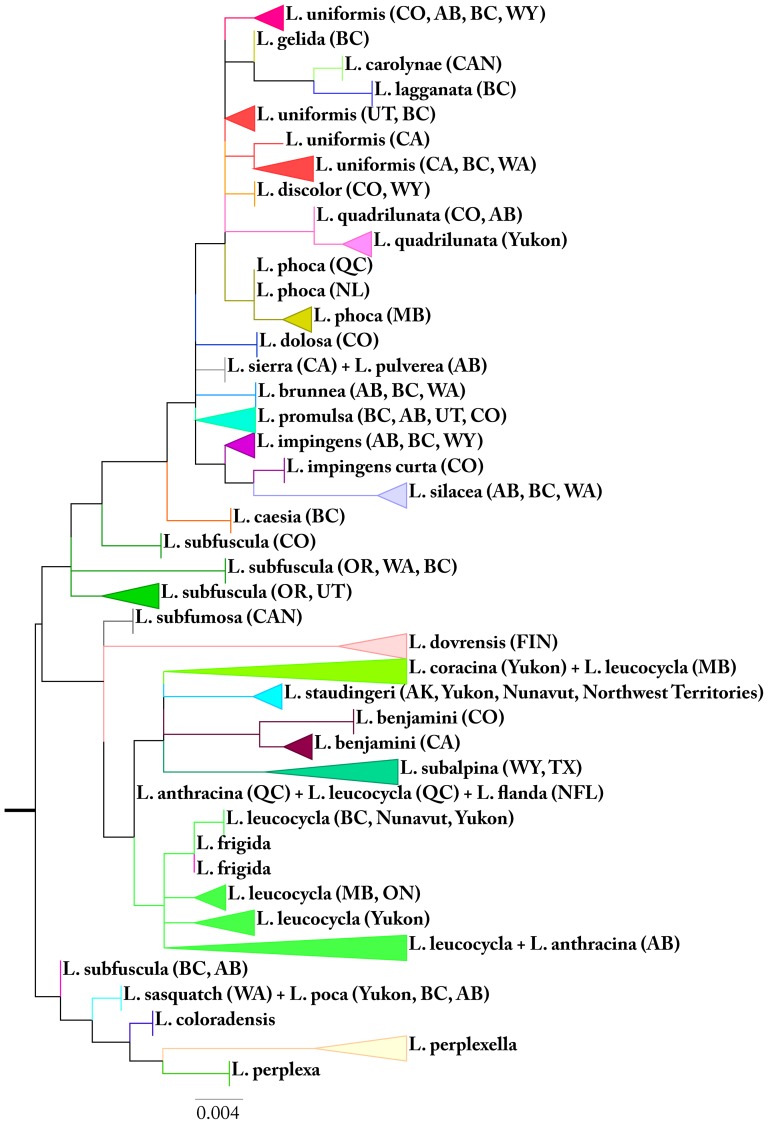
Low sequence divergence in Lasionycta.Maximum likelihood tree (COI barcode) for Lasionycta demonstrating very low sequence divergences and cases of overlapping or shared haplotypes. Terminals with vertical bars indicate one or few samples shared identical haplotype, those with trianglesrepresenting collapsed haplotypes with less than 2% sequence divergence. Geographic origin is given in brackets as standard abbreviations for provinces (Canada) or states (USA); FIN  =  Finland.